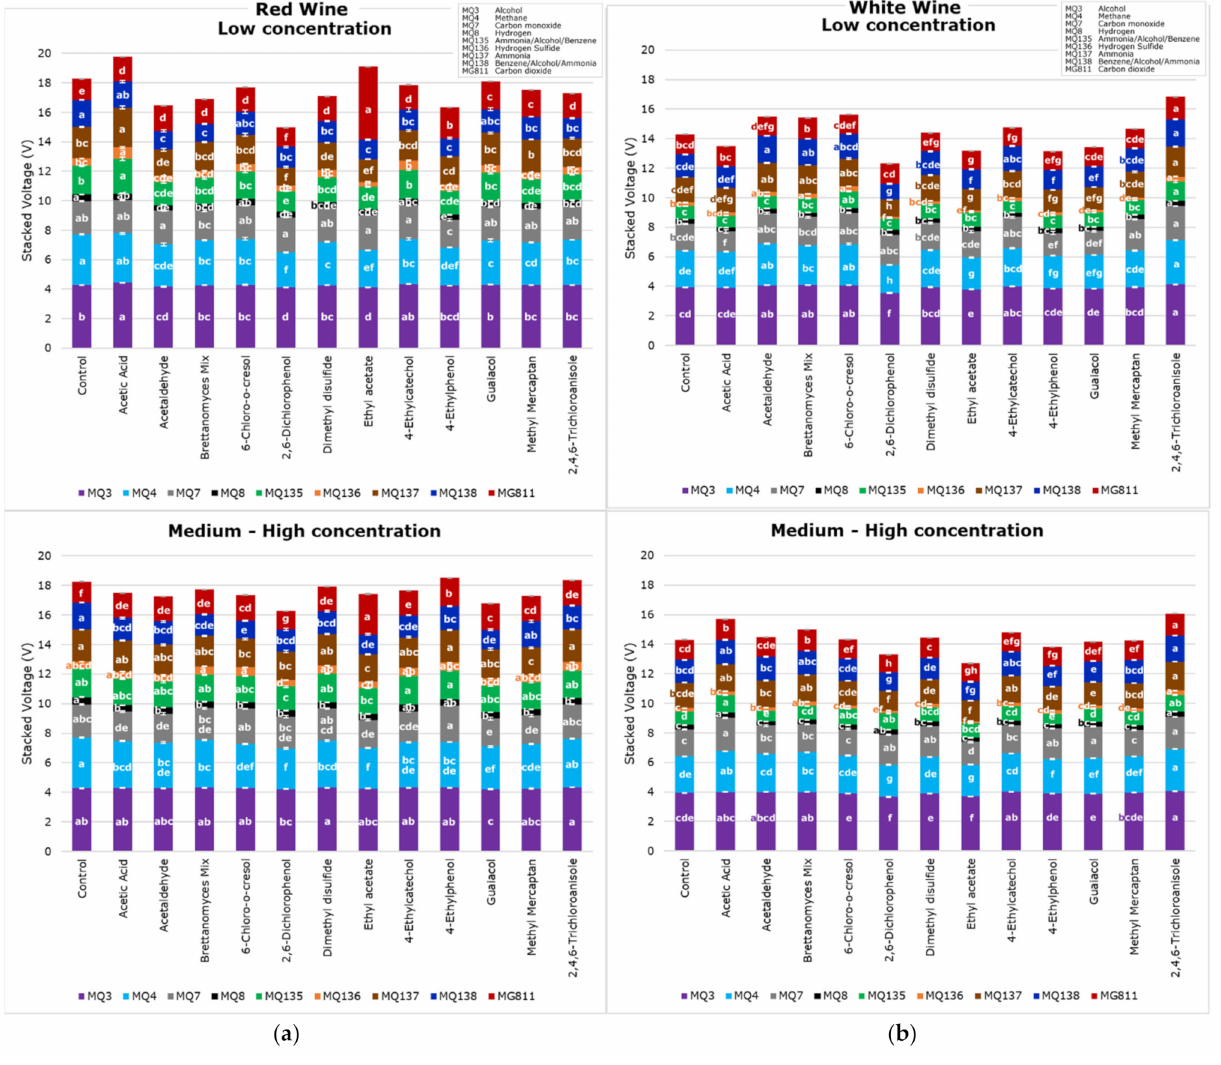
Figure 4. Electronic nose mean values from each gas sensor for ( a ) red and ( b ) white wine for low and medium–high concentration samples, showing the letters of significance (a–h) between samples based on Tukey’s honest significant difference (HSD) test ( p < 0.05). Table 3. Accuracy and performance based on means squared error (MSE) of machine learning models 1–6 developed for red